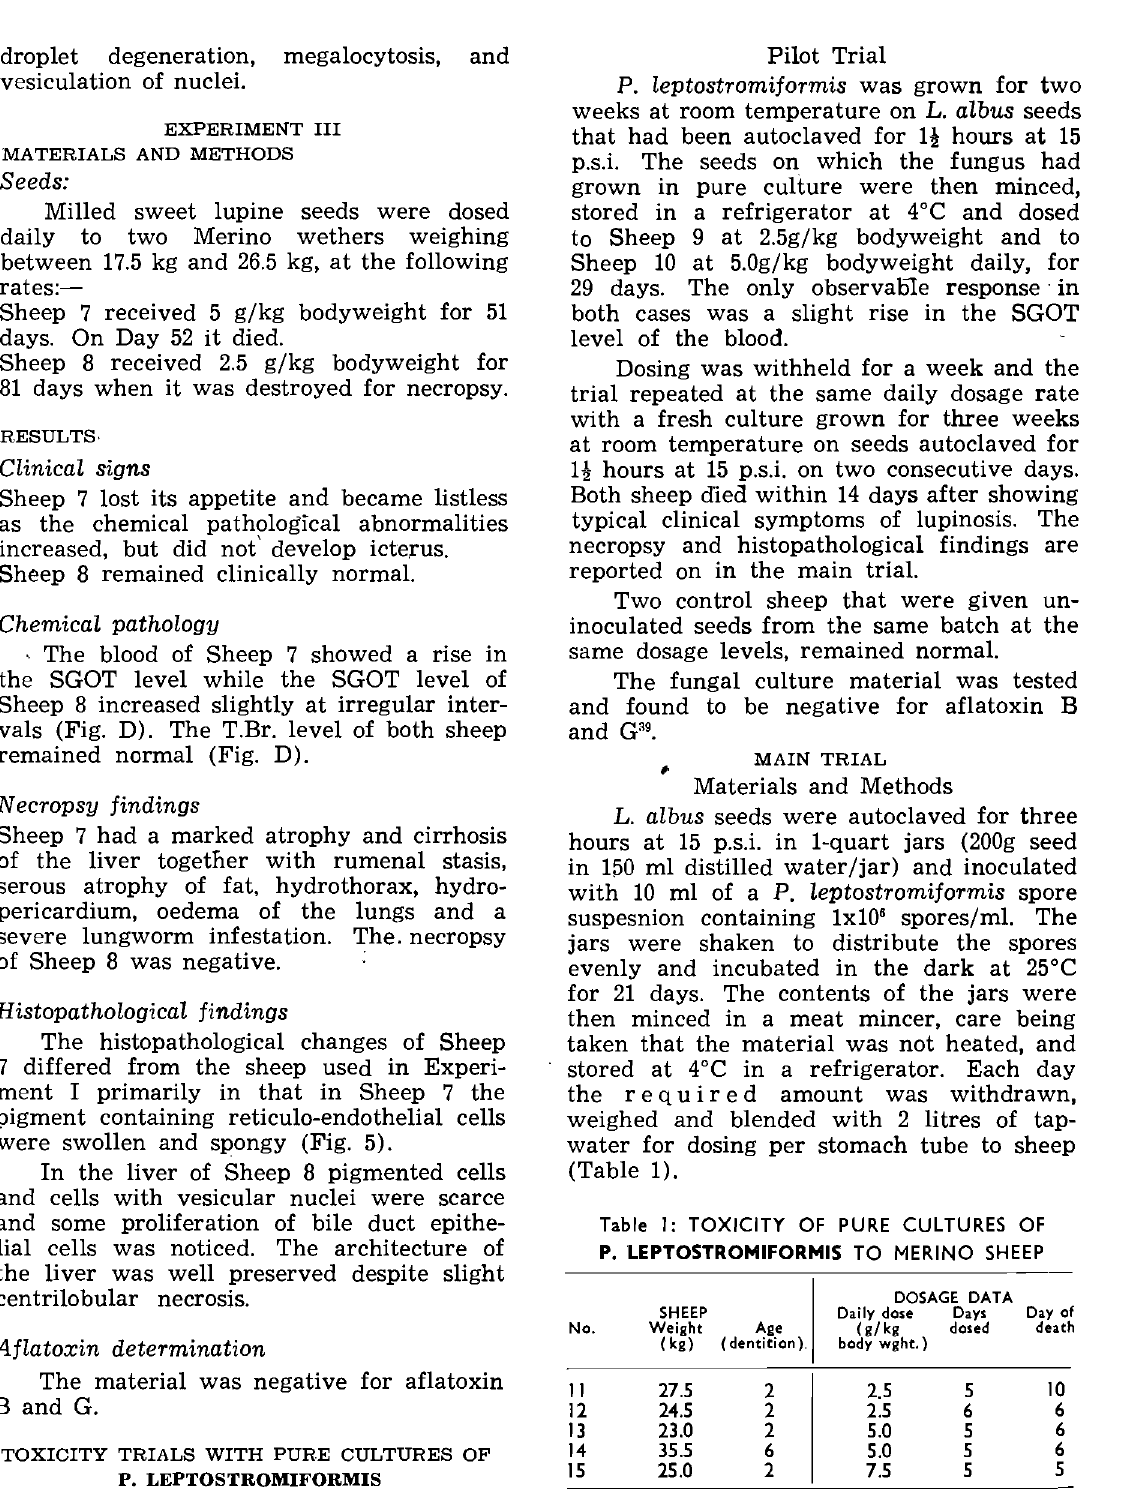
Table J: TOXICITY OF PURE CULTURES